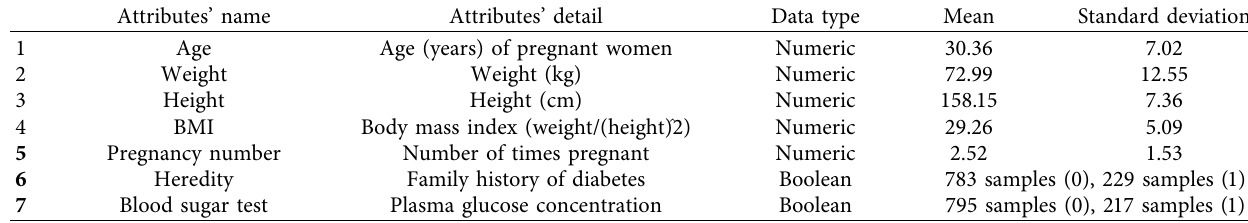
Table 2: The attributes’ description.